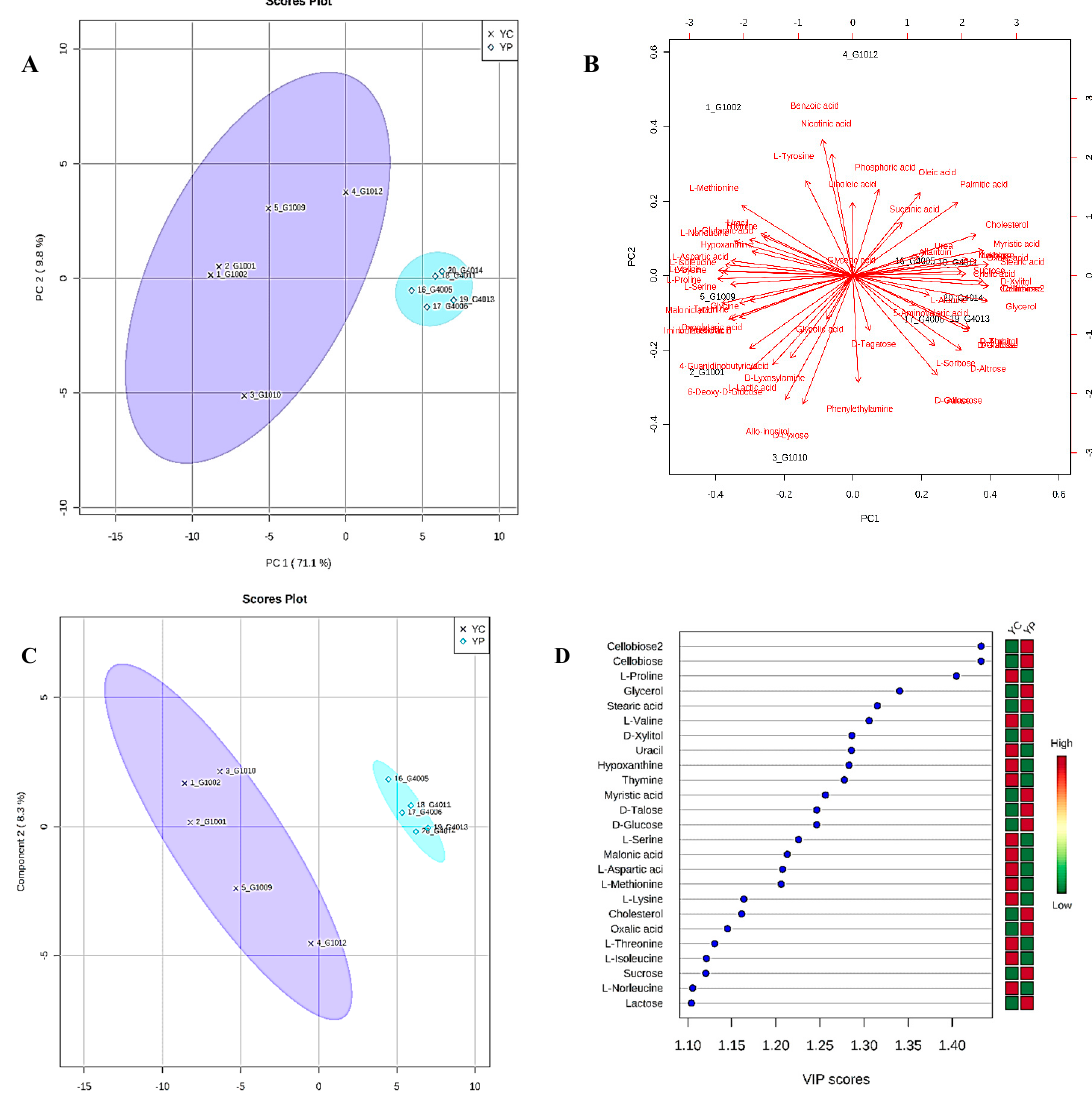
Figure 4. ( A ) Principal component analysis (PCA) plot of feces collected from young control (YC, violet color) and young treatment groups (YP, blue color) showing divergence. ( B ) Bi-plot showing compounds responsible for divergence. ( C ) 2D-PLS-DA plot showing spatial division among groups. ( D ) Key compounds separating YC and YP based on variable importance in projection (VIP) score plot in PLS-DA analysis.